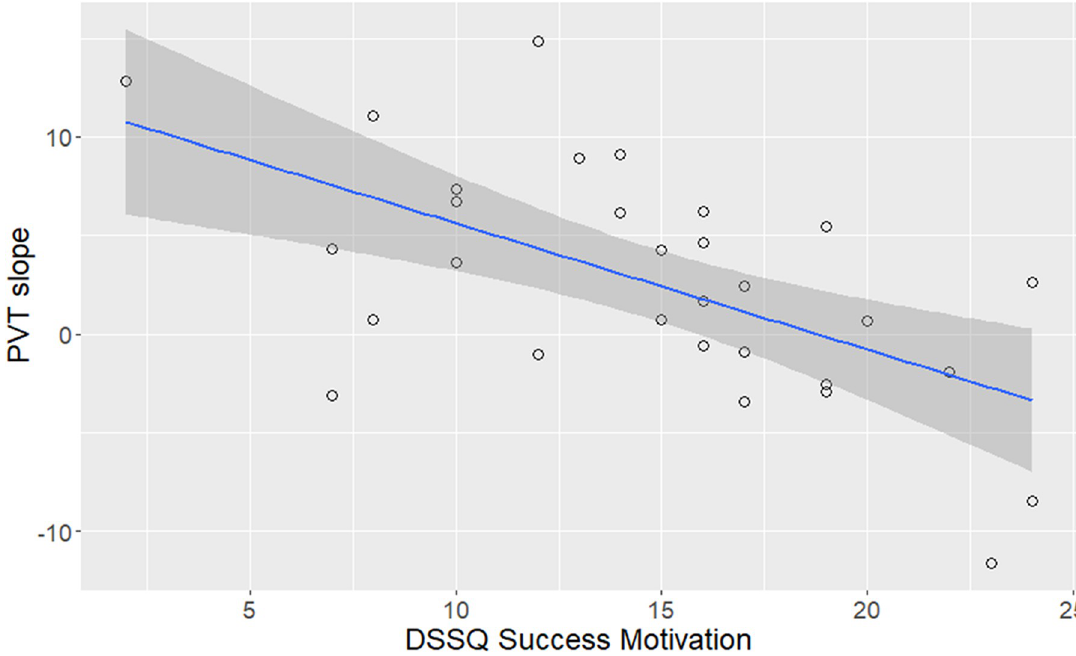
Fig 6. Performance detriment is inversely proportional to motivation for success in the task (FDR-corr. p < 0.05). Performance detriment was measured as the linear slope of reaction time (RT) through a Psychomotor Vigilance Task (PVT); success motivation was measured via the Dundee Stress State Questionnaire (DSSQ). The solid blue line and shaded area indicate the linear regression line and its confidence interval, respectively.